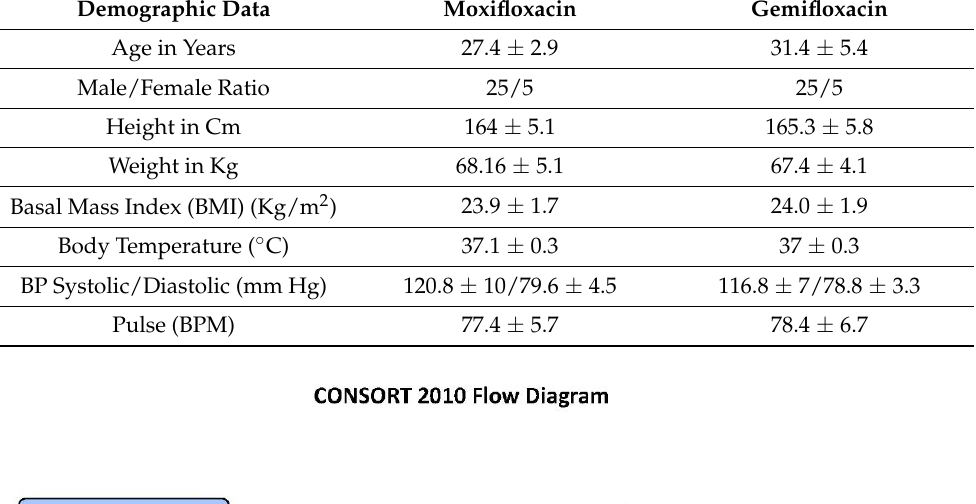
Table 1. Baseline characteristics of the participants plotted as mean ± SD.